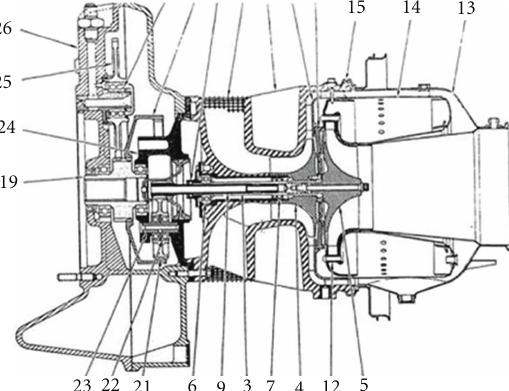
Figure 9: Schematic of SwRI research gas